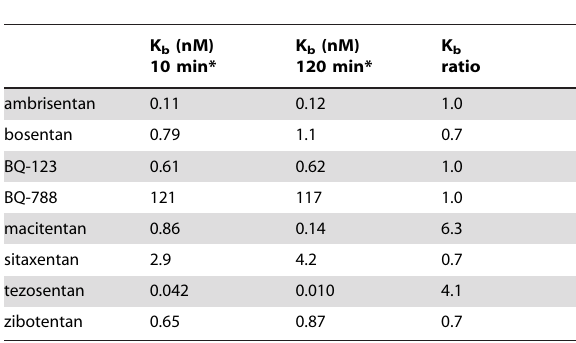
Table 2. Mean K b values for different ERAs determined by calcium release assays in human PASMC with 10 min or 120 min antagonist pre-incubation time.